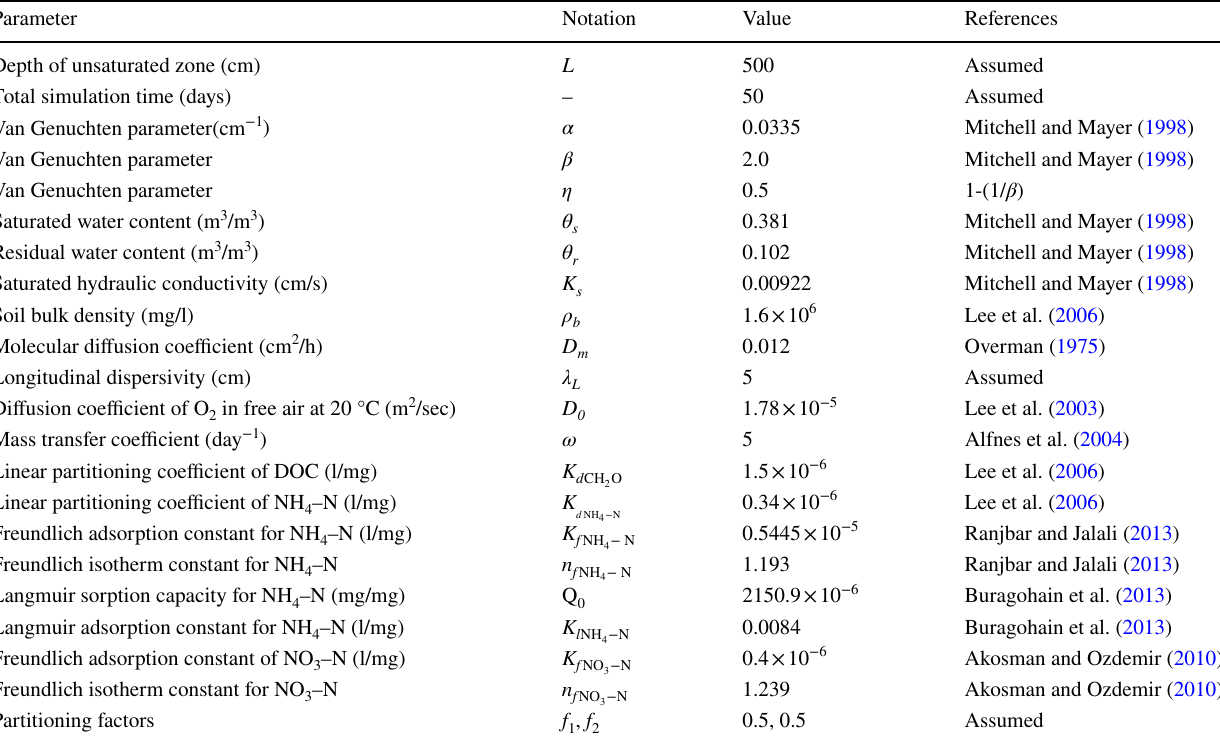
Table 2 Hydrodynamic properties and transport parameters for an unsaturated zone